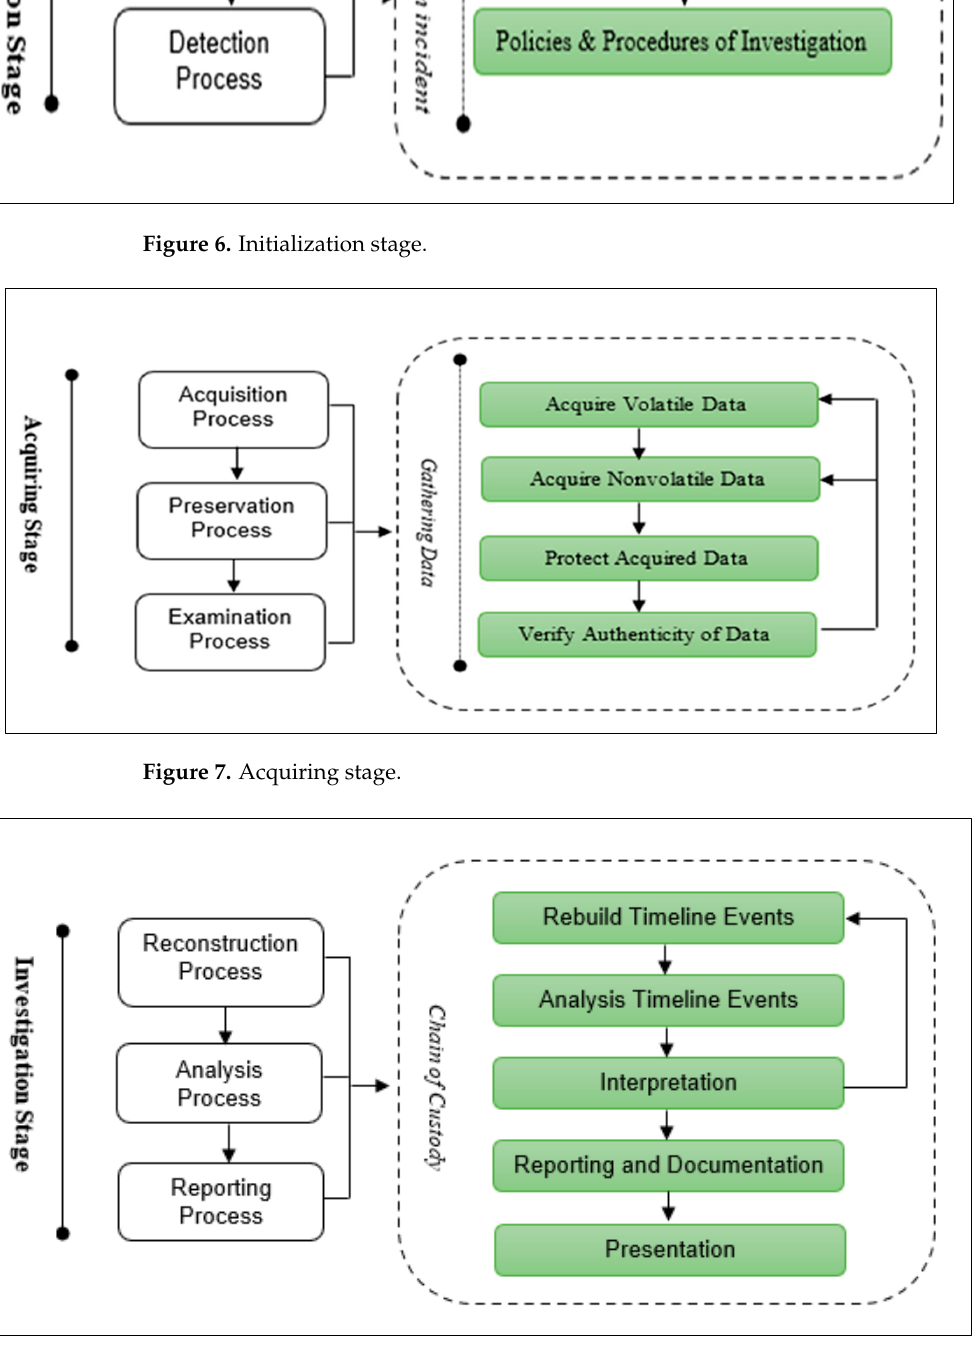
Figure 8. Investigation